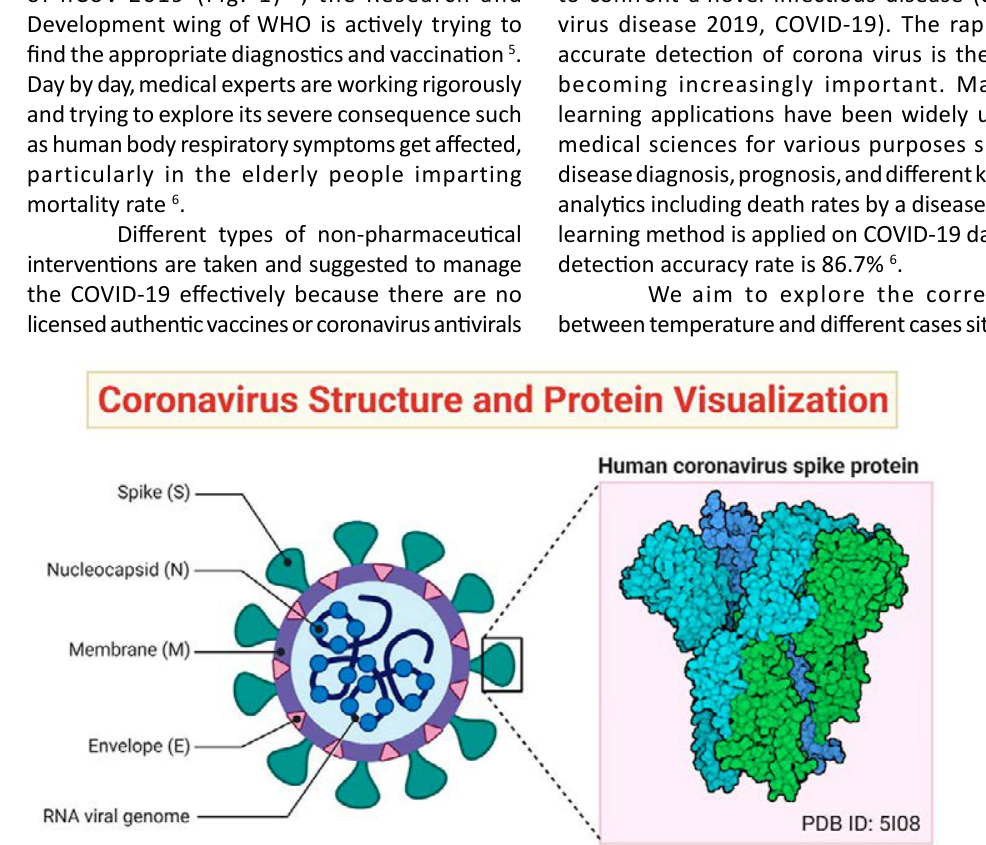
Fig. 1. The 2019-nCoV structure. Coronaviruses belong in the family Coronaviridae and can cause disease in mammals and birds. The coronavirus spike (S) protein mediates membrane fusion by binding to cellular receptors.